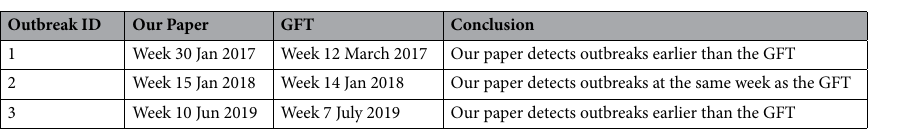
Table 10. First spike date comparison of this paper’s outbreak detection vs. the GFT for the southern region in sample periods.